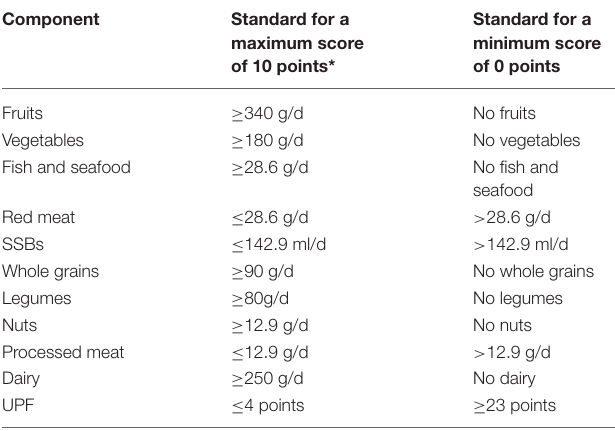
TABLE 1 | Cardiovascular Health Diet Index components and standards for scoring. Component